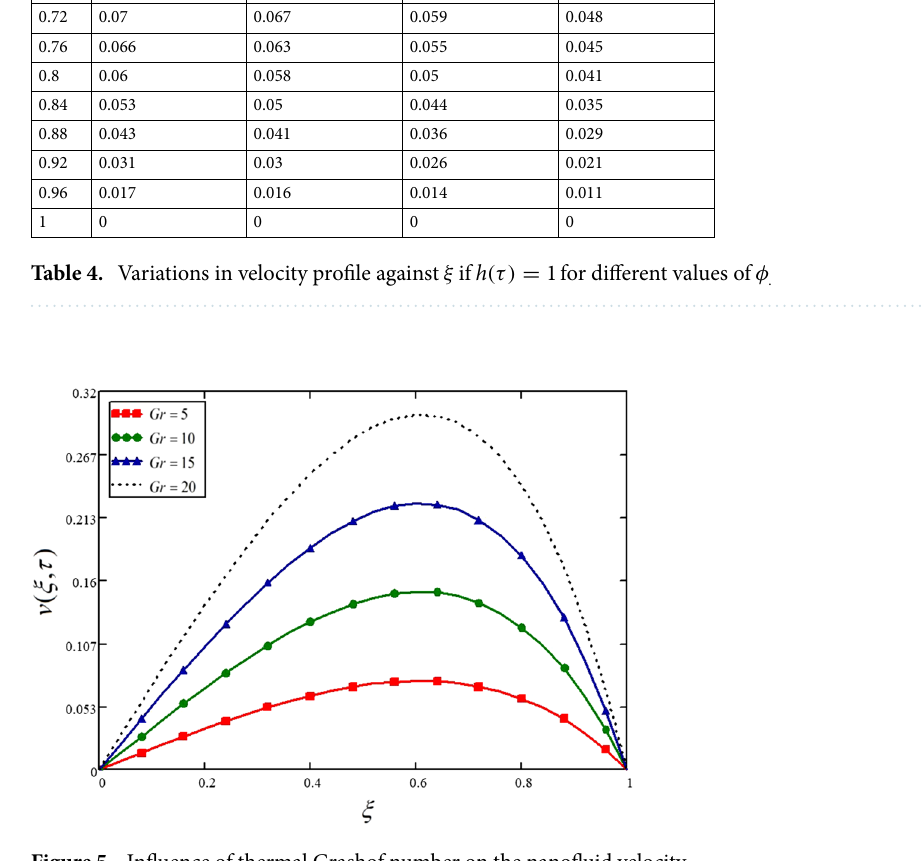
Figure 5. Influence of thermal Grashof number on the nanofluid